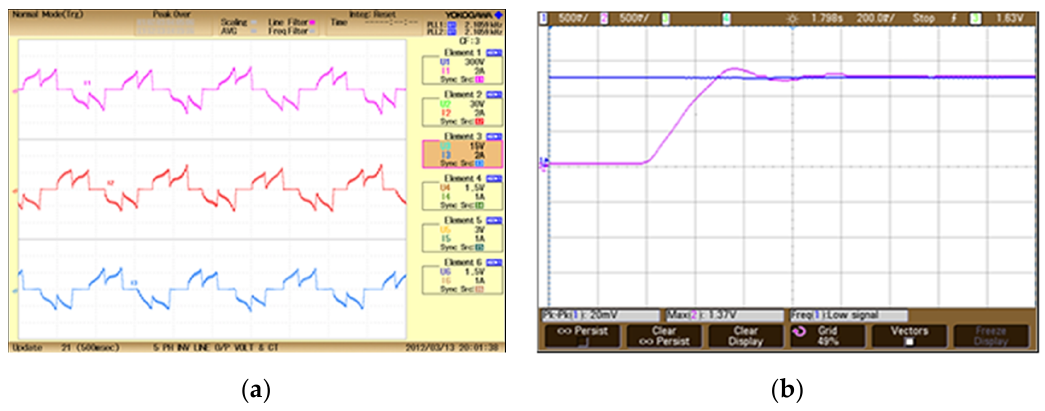
Figure 16. The brushless motor ( a ) current and ( b ) speed waveform.